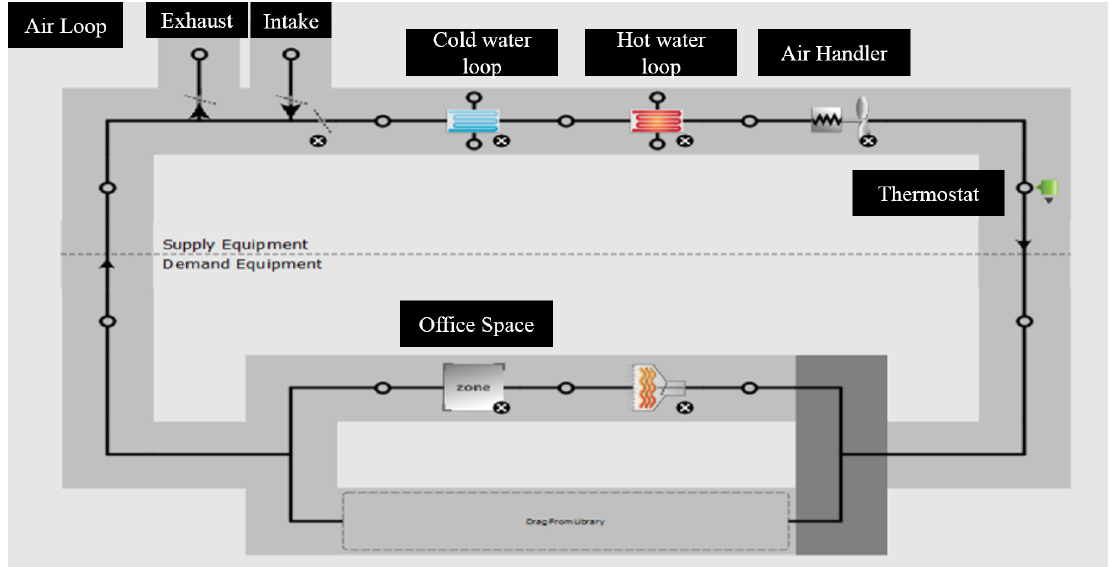
Figure 4. Layout of the simple Variable Air Volume (VAV) HVAC Loop implemented within our room zone simulation. This was a plug-and-use (VAV) module available when designing the building in